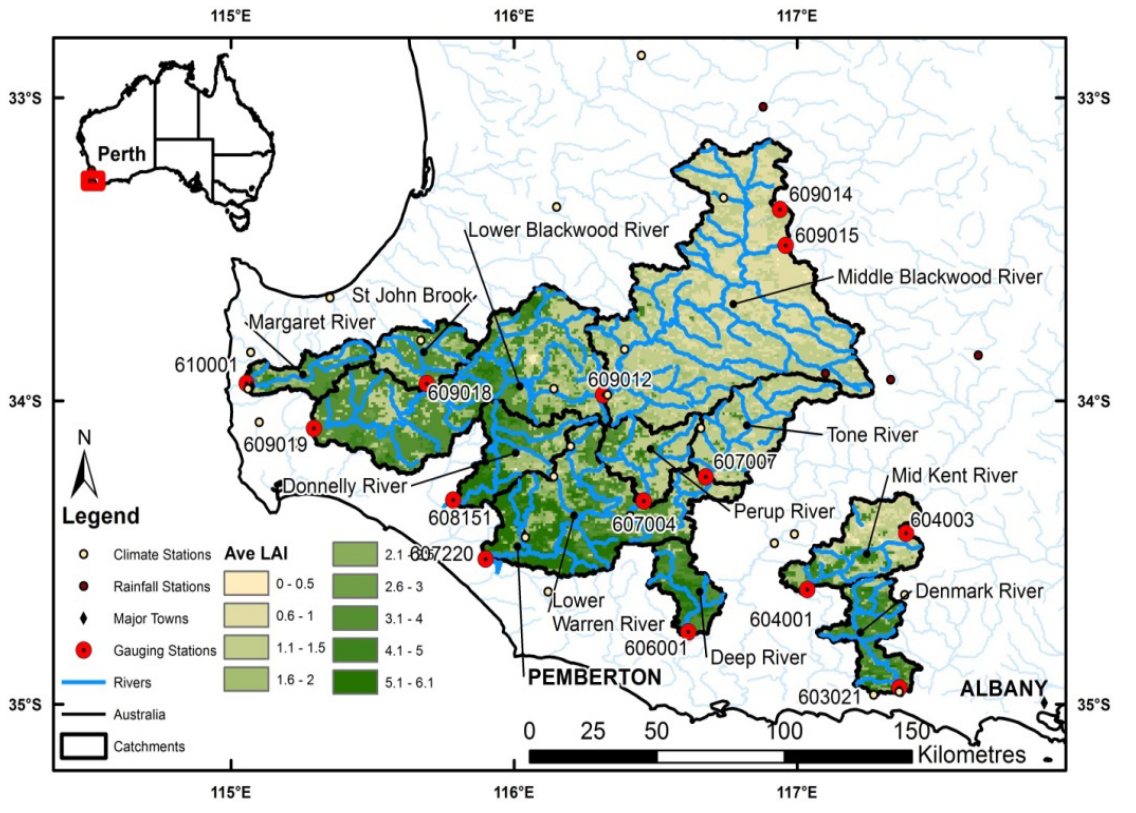
Figure 1. Location of study catchments in South-west Western